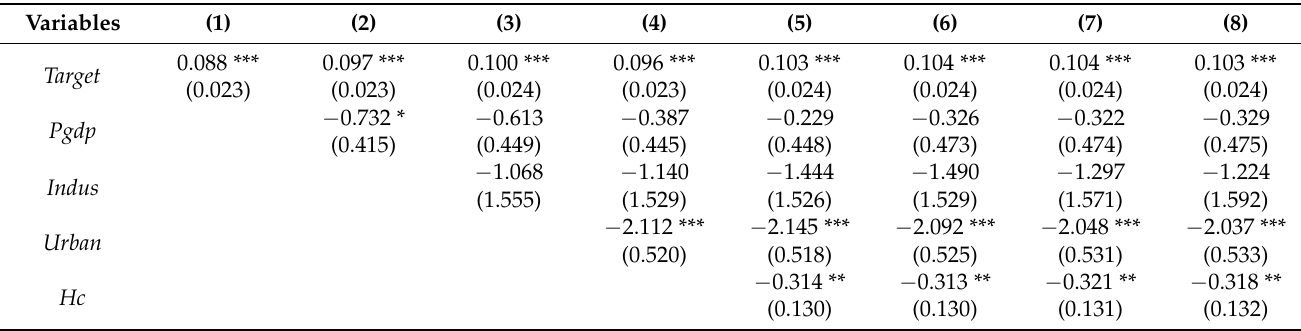
Table 2. Basic regression